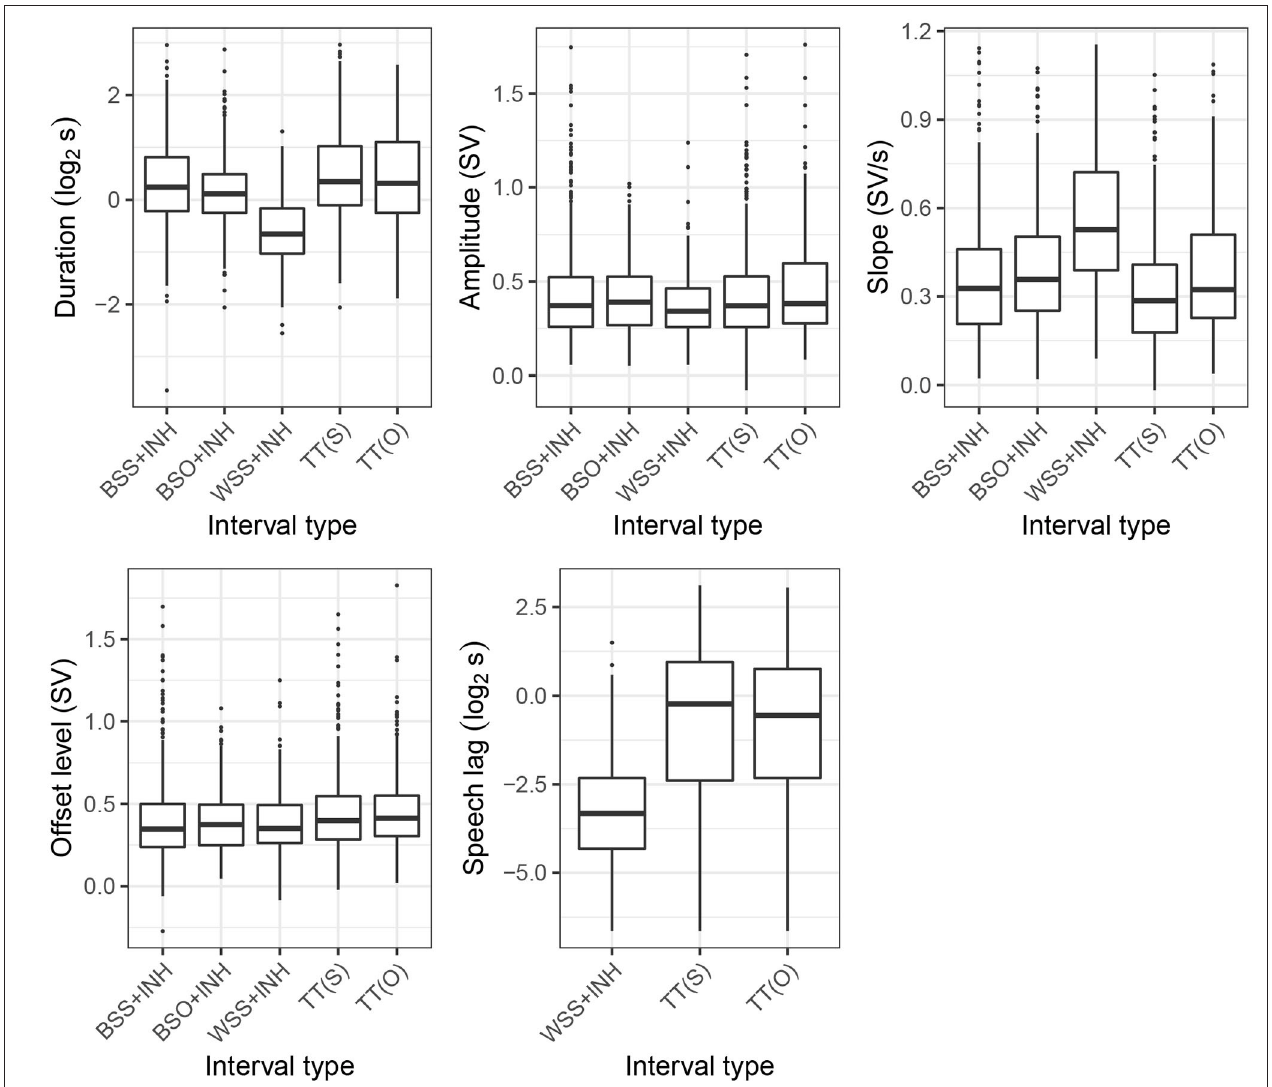
FIGURE 6 | Distribution of inhalatory features across the interval types. See section 3 for explanation of the